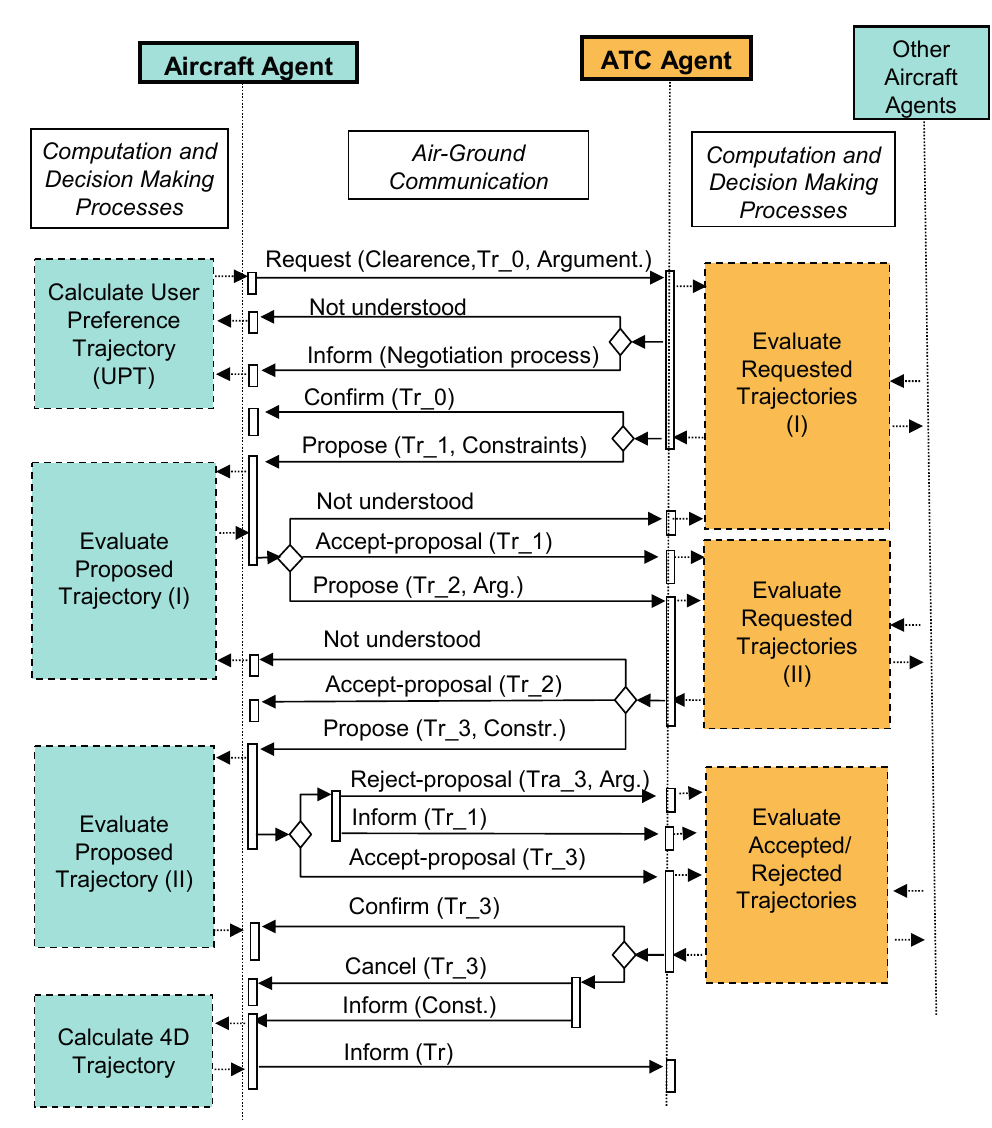
Figure 5. Air-Ground Negotiation Protocol